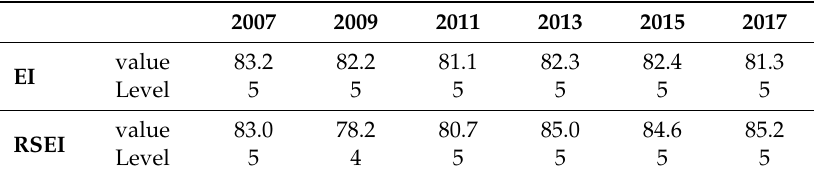
Table 7. Comparison between EI and RSEI